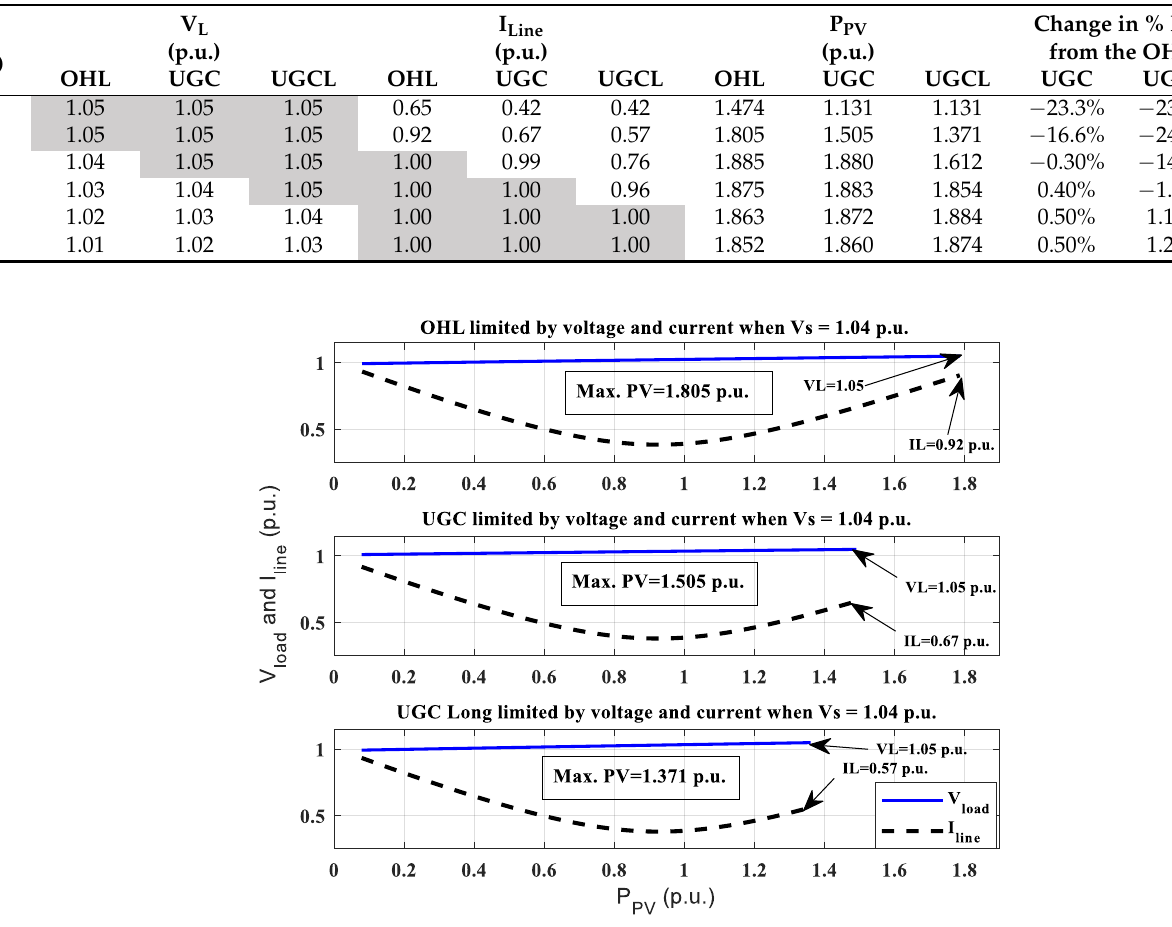
Figure 8. PV maximum penetration limited by voltage and current for different feeders (Substation voltage 𝑉 𝑆 = 1.04 p.u.) .